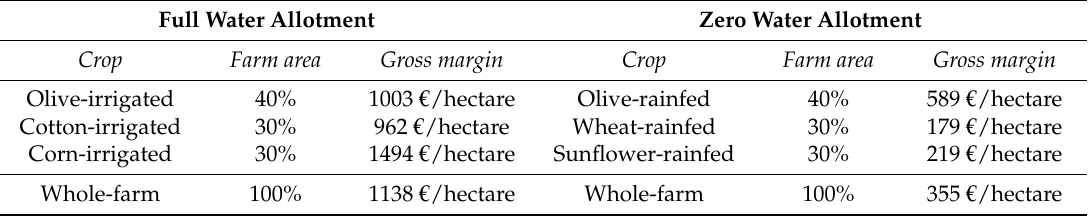
Table 3. Gross margins with full and zero water allotments. Assessment of insured capital ( IC ) 1 . Full Water Allotment Zero Water Allotment Crop Farm area Gross margin Crop Farm